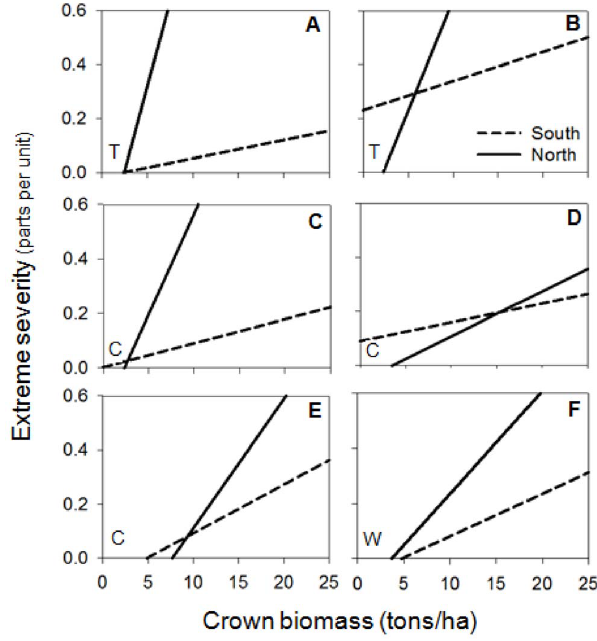
Figure 3. Significant interactions of Aspect (north or south) and Crown Biomass (tons/ha) on extreme fire severity (parts per unit). Letters in the top-right corner indicate the fire: (A) Bot 2000; (B) Castellbisbal 2002; (C) Margalef 2005; (D) Cardona 2005; (E) Castellnou de Bages; (F) Mont-roig del Camp 2007. Letters in the bottom-left corner indicate the fire type: (T) topographic fires; (C) convective fires; (W) wind-driven fires.